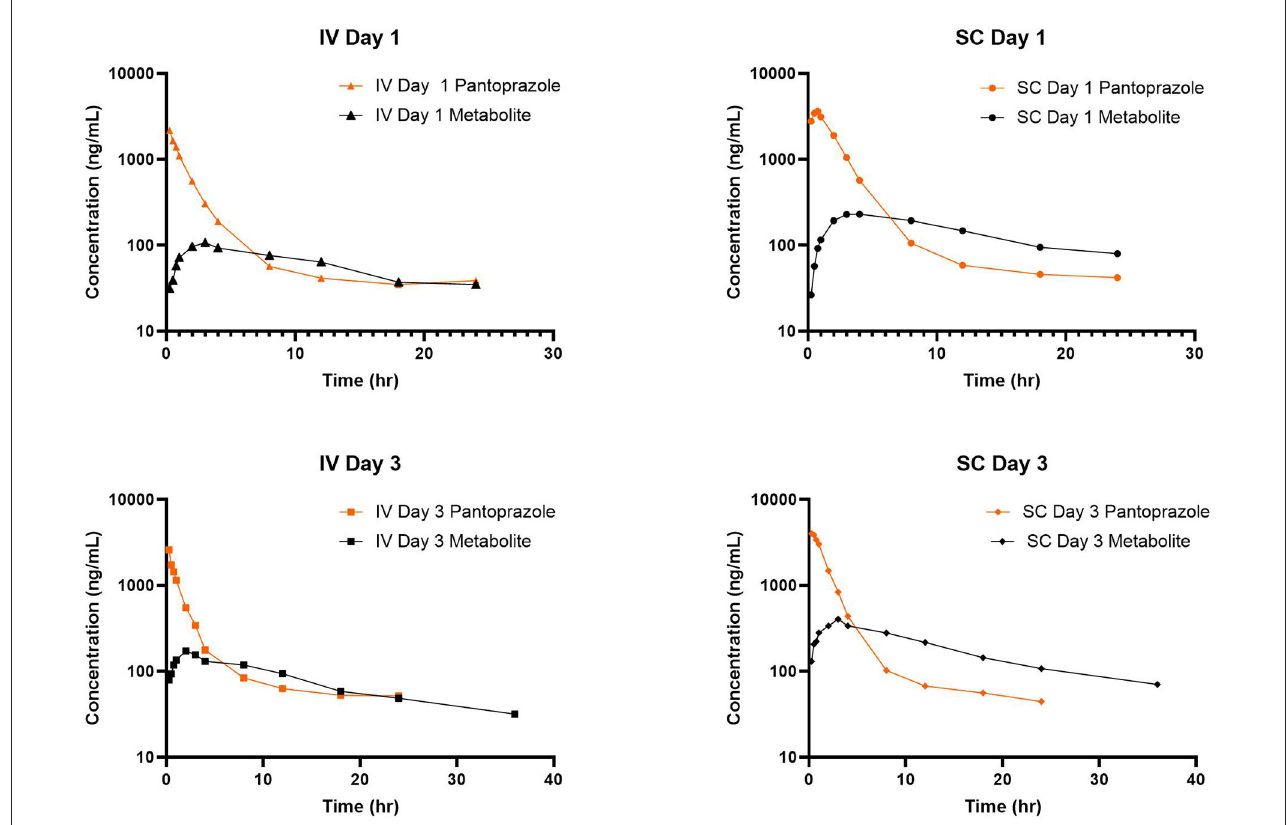
FIGURE6 Comparison of time vs. concentration for parent and metabolite for each day and route of administration.